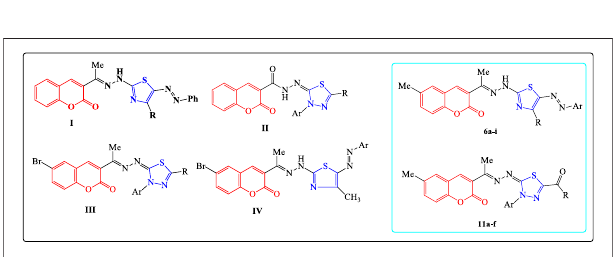
FIGURE 2 | Coumarin-based thiazoles or thiadiazoles with anticancer activities and the targeted compounds.